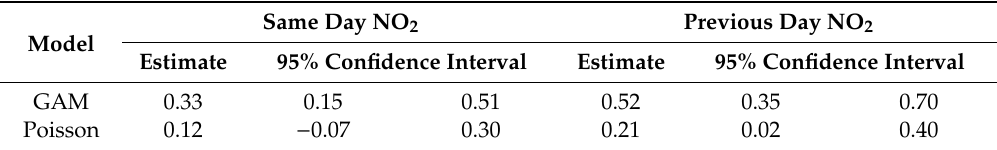
Table 2. E ff ect estimates (% change per 10 µ g / m 3 NO 2 ).